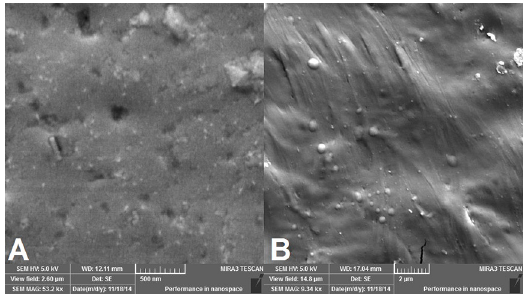
Figure 5. Micrograph of the Van Gogh membranes, (a) M1 and (b) M2.